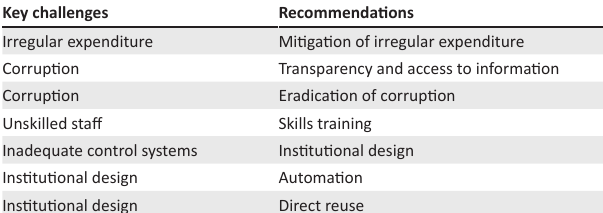
TABLE 1: Key challenges and recommendations. Key